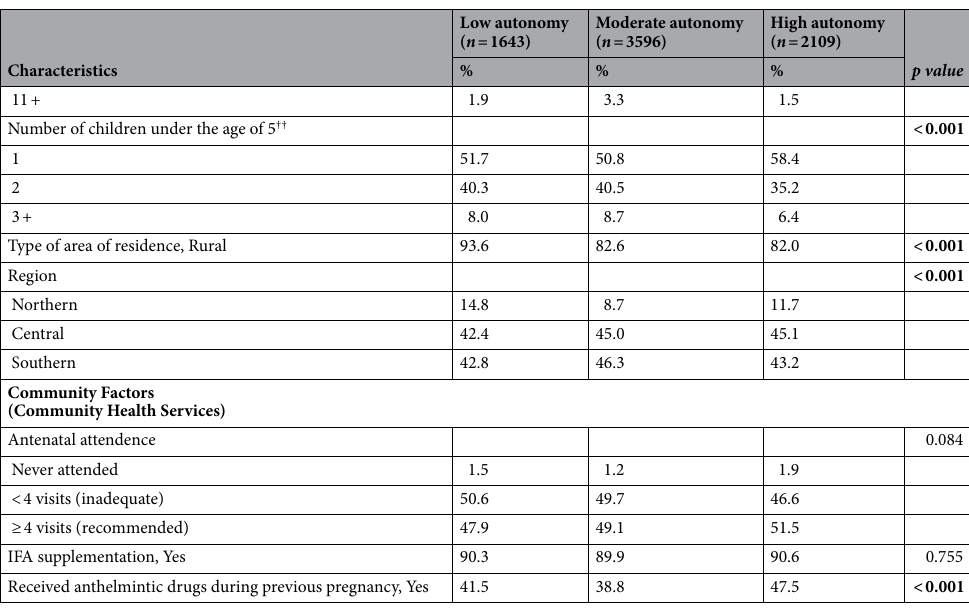
Table 2. Characteristics of pooled participants by maternal autonomy ( N = 7,348). p , Pearson’s chi-square p value; †† Total count < n ; BMI, body mass index; IFA, iron and folic acid; SD, standard deviation. Statistical significance was set at p < 0.05. Significant p values are in boldface.